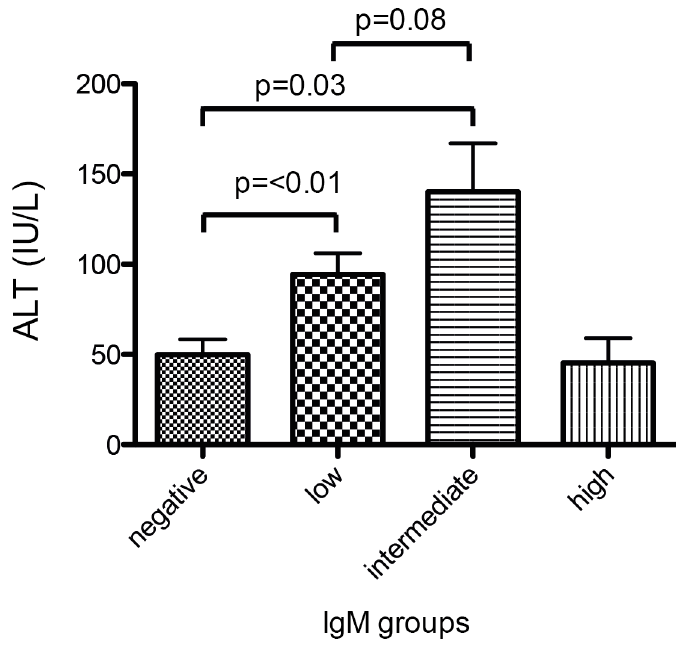
Figure 3. Distribution of ALT values according to Anti-HDV IgM categories in the MHH cohort (only significant p-values). The association of anti-HDV IgM and ALT was confirmed in the MHH cohort with significance over all groups of 0.03.